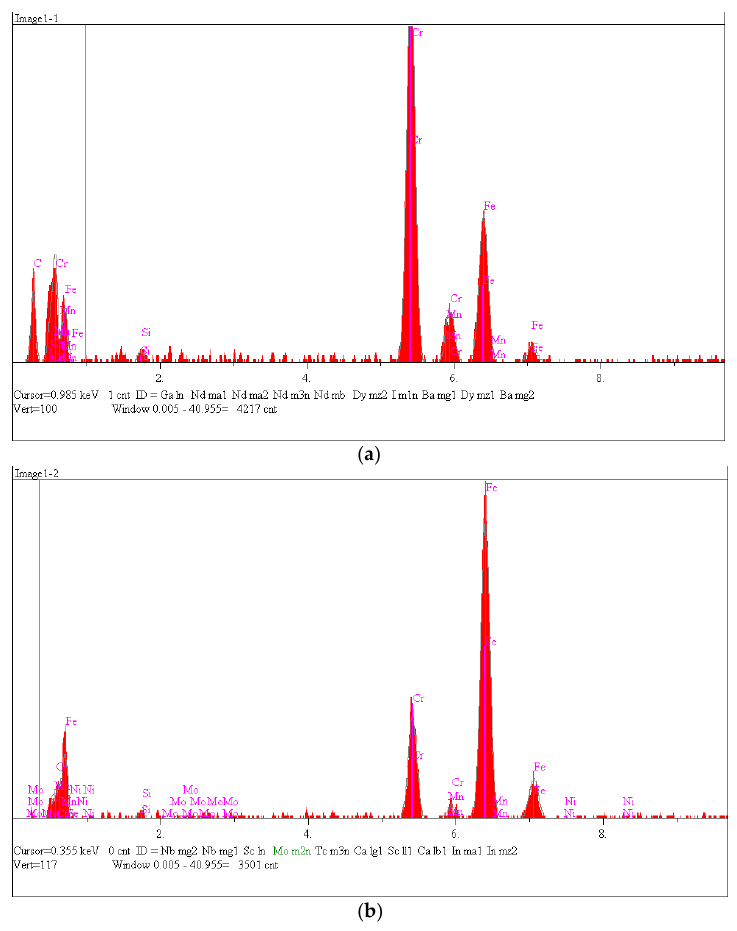
Figure 12. Scanning microscope analysis of reference sample: ( a ) qualitative EDS analyses from Point 1 (carbide); ( b ) qualitative EDS analyses from Point 2